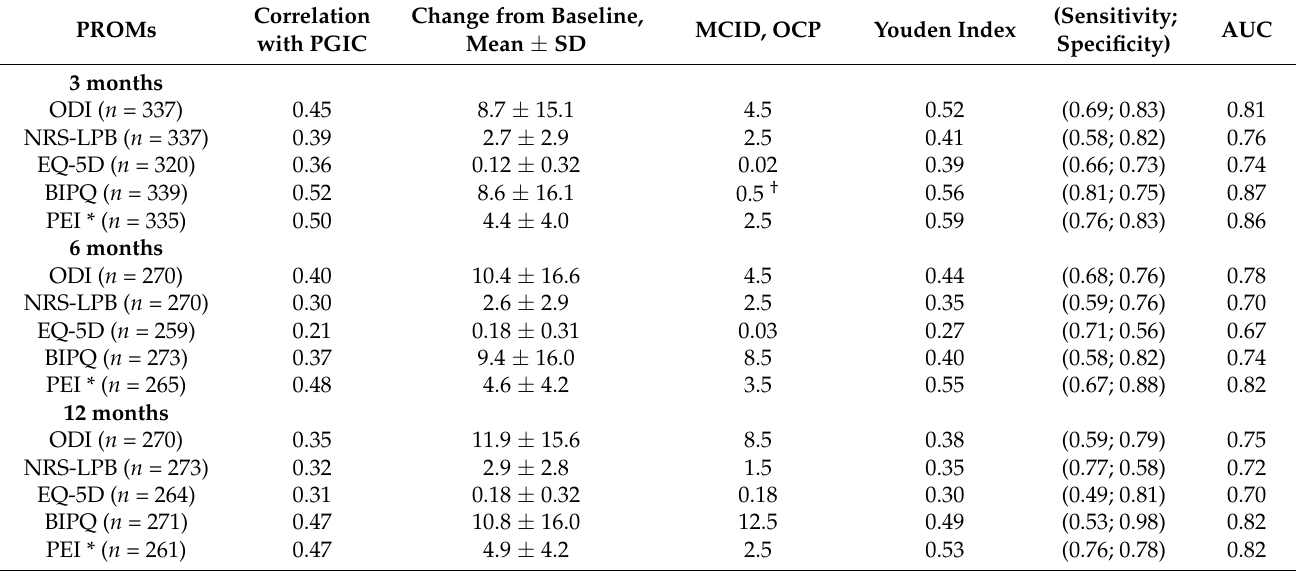
Table 3. Minimal clinically important differences (MCID) interpreted with optimal cut-off point (OCP) at baseline to follow-up for the total study